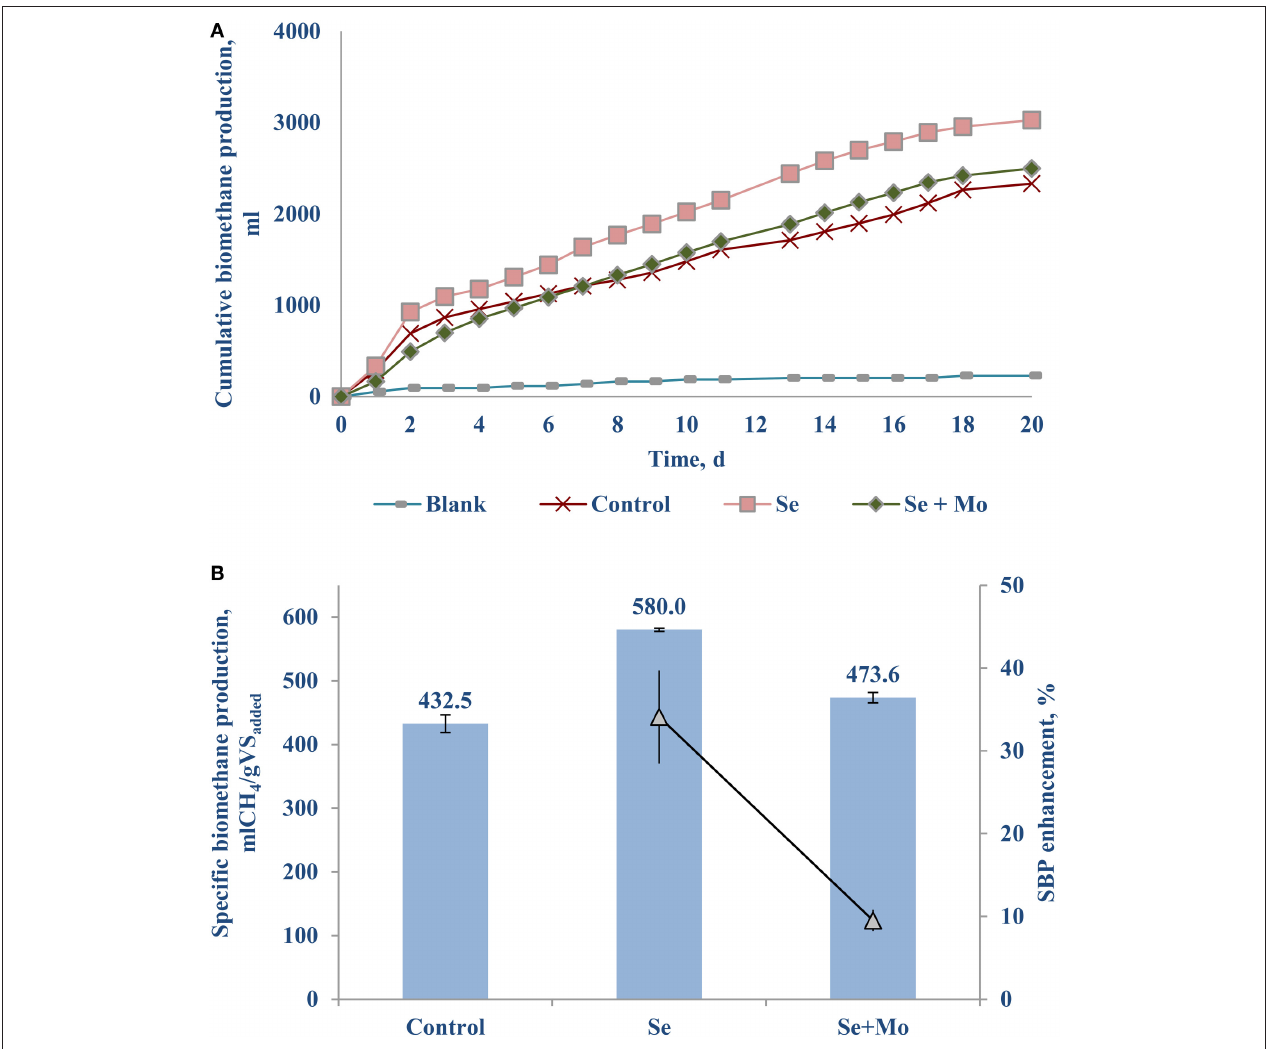
FIGURE 4 | Effect of TE (VI) on the SBP of FW-A: (A) Cumulative methane curves; and (B) SBP.